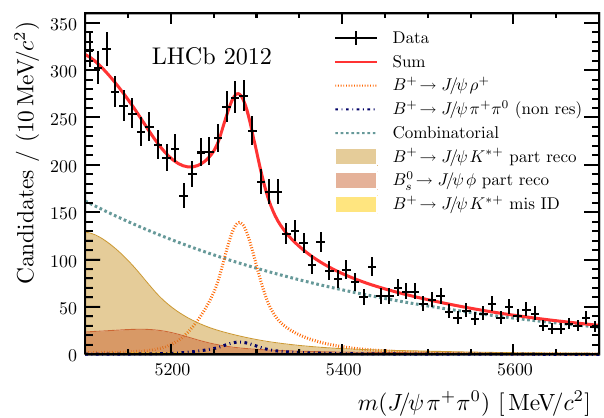
Fig. 3 The J /ψ π + π 0 invariant mass distributions for the (left) 2011 and (right) 2012 data sets. In the legend, “non res” stands for non- resonantbackground,“partreco”forpartiallyreconstructedbackground